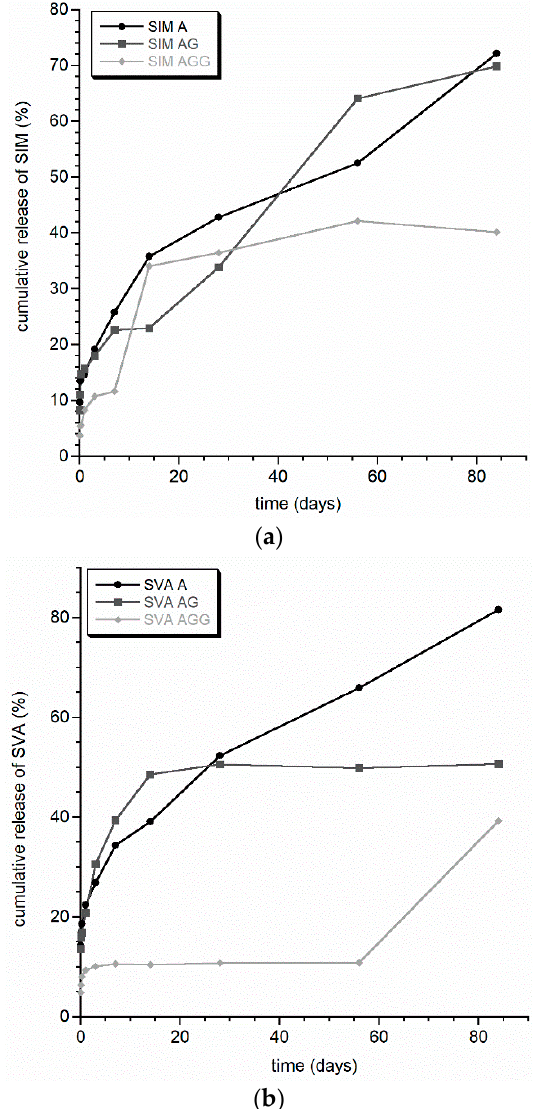
Figure 5. SIM ( a ) and SVA ( b ) release curves from A, AG, and AGG granules. The overall cumulative release did not vary significantly between the two different forms of simvastatin, lipophilic (SIM) or hydrophilic (SVA). Nevertheless, it should be concluded that the cross-linking between covalent gelatin and glutaraldehyde significantly delays the release of the model drug. This may be related to the low pore’s surface of the (SIM/SVA) AGG beads, which makes them the least degradable. Three profiles (SIM AG, SIM AGG and SVA AGG) exhibited more than one plateau. The authors believe that in case of the (SIM/SVA) AG beads, this may be attributed to their bimodal distribution of pores, as already mentioned. In turn, due to the fact that both SIM AGG and SVA AGG possess the same pore structure, the existence of two plateaux can be related to the electrostatic interactions between both forms of simvastatin and covalently crosslinked gelatin. Interestingly, only in the case of the (SIM/SVA) AGG beads was a slight difference between the release profile of SIM and SVA observed. Although the overall release of the model drug was at a similar level, for SVA the first plateau was observed for a significantly longer period of time. This suggests possible stronger electrostatic bonds between SVA and crosslinked